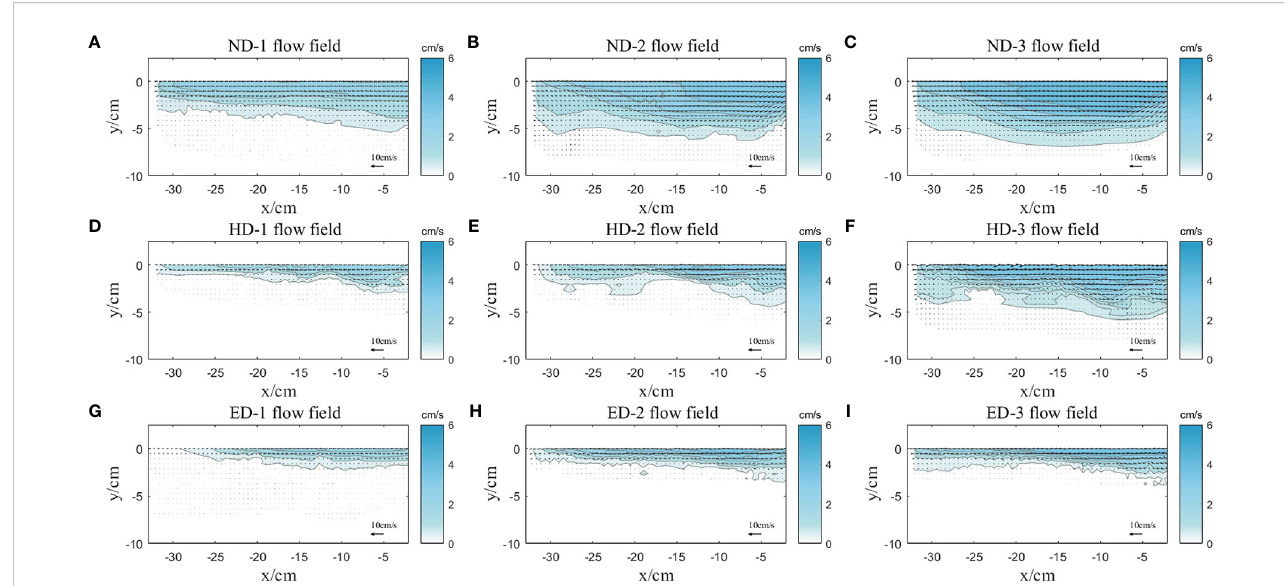
FIGURE 4 Flow fi eld of the river plume in all cases: Case ND-1 (A) , Case ND-2 (B) , Case ND-3 (C) ,Case HD-1 (D) , Case HD-2 (E) , Case HD-3 (F) , Case ED-1 (G) , Case ED-2 (H) and Case ED-3 (I)